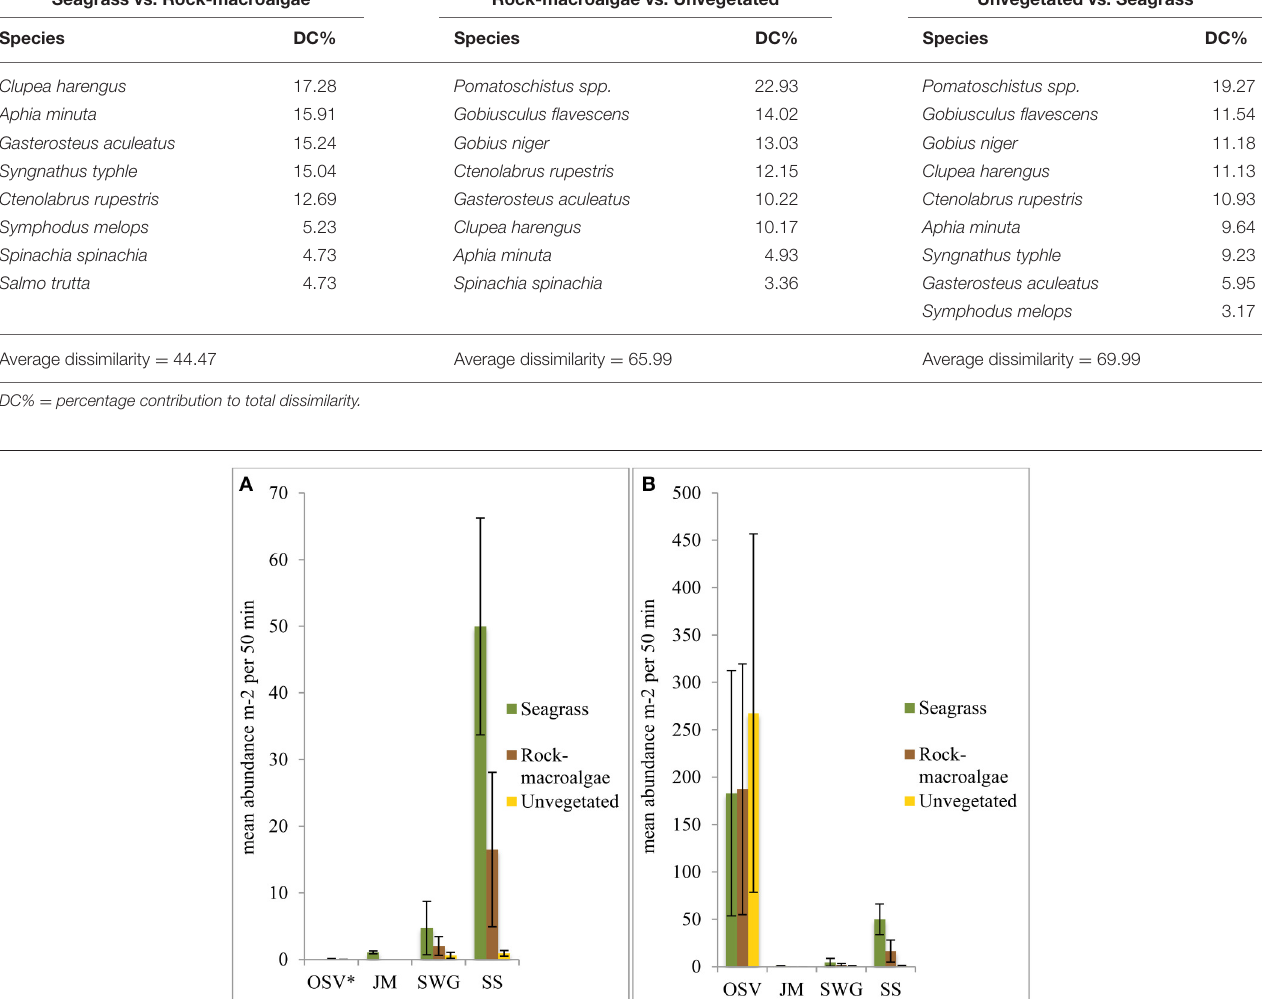
TABLE 3 | SIMPER analysis results for fish species (based on presence/absence data) contributing most to dissimilarities among habitats (cumulative limit of 90%). Seagrass vs. Rock-macroalgae Rock-macroalgae vs. Unvegetated Unvegetated vs. Seagrass